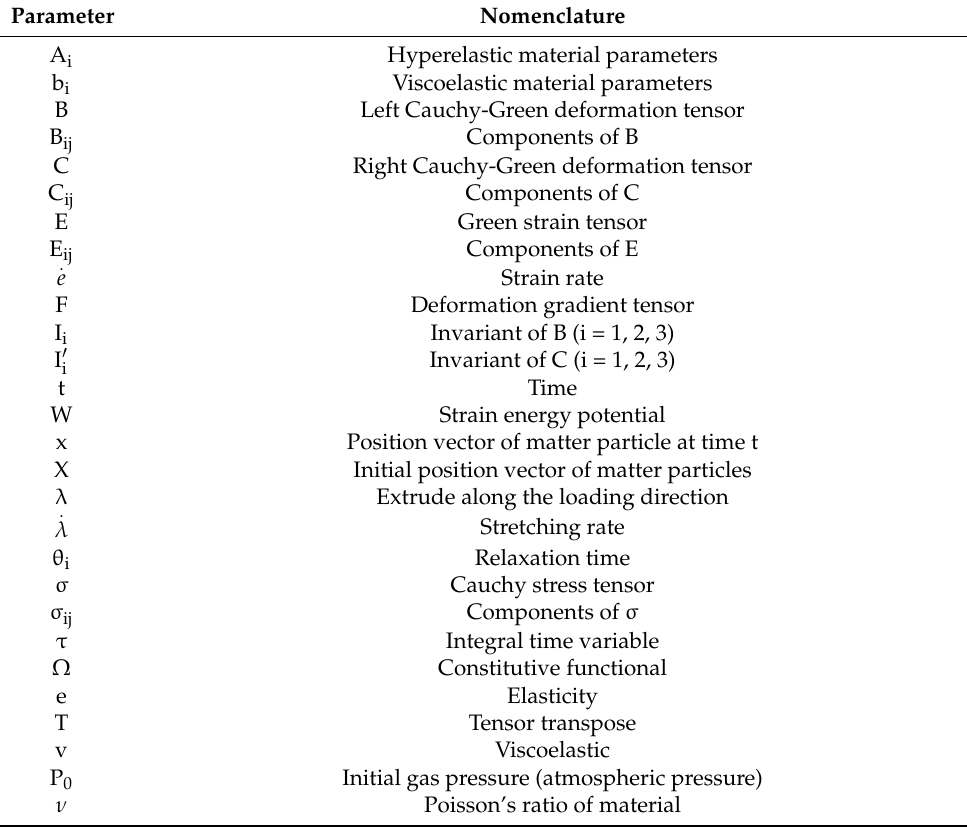
Table 4. The meaning of model parameters